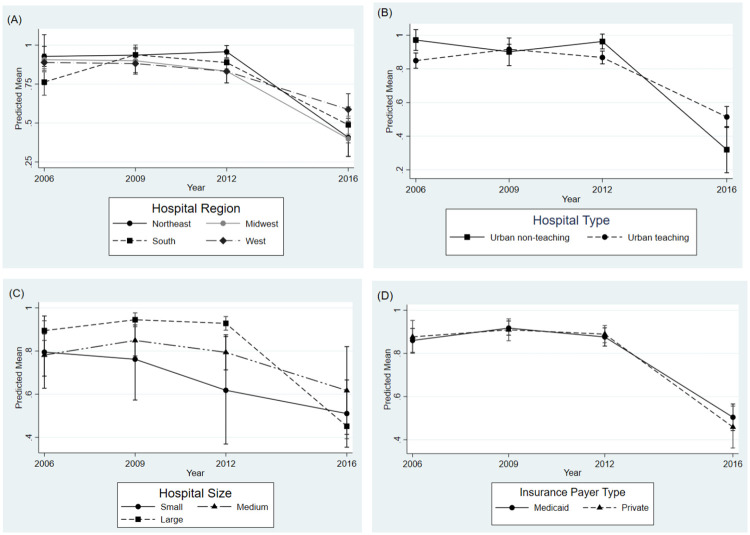
Trends in LVS non-indicated MRI across cycles.Panel A: Stratified by Hospital Region. Panel B: Stratified by Hospital Type. Panel C: Stratified by Hospital Size. Panel D: Stratified by Insurance Payer Type.